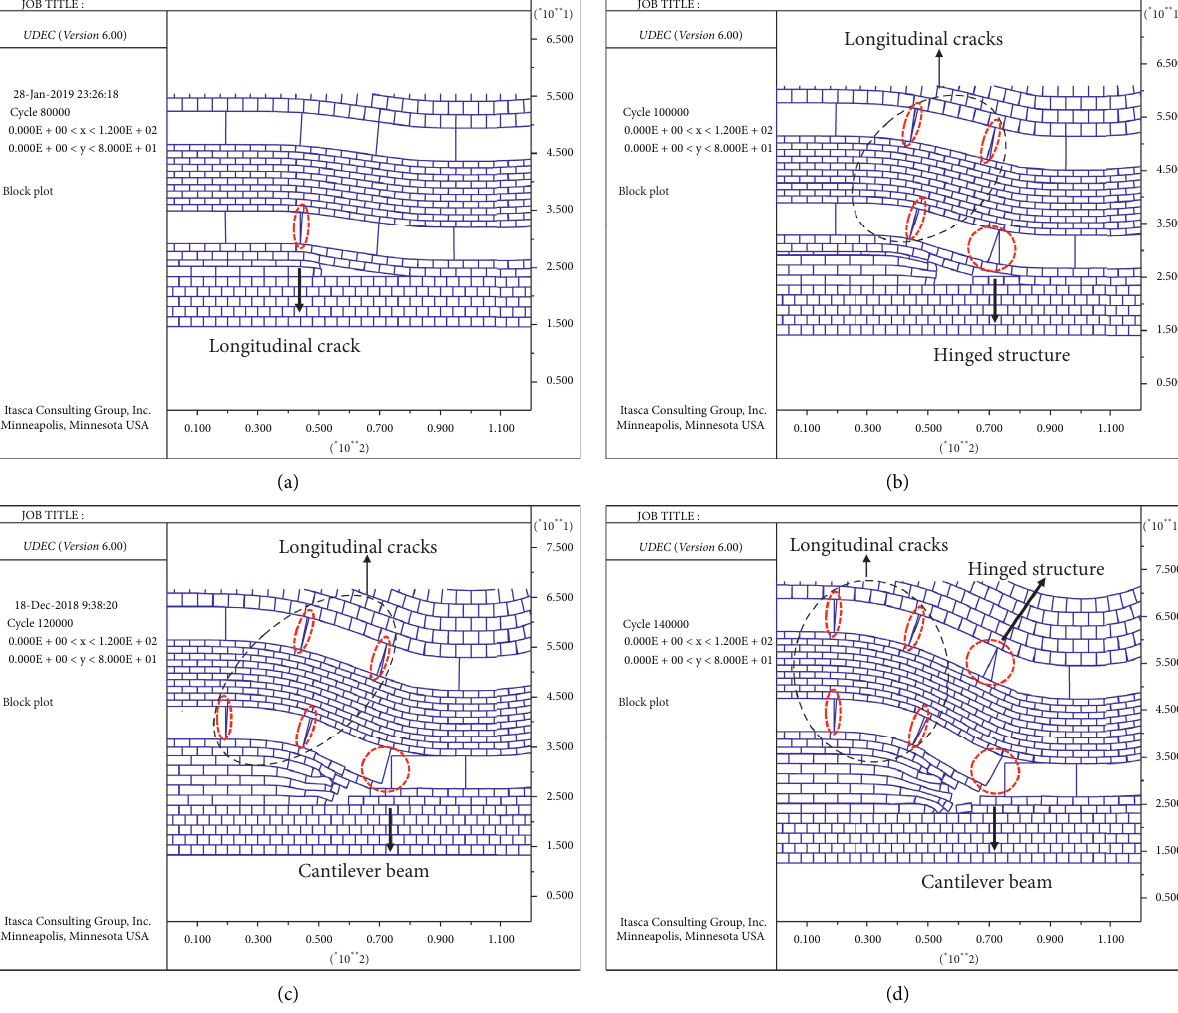
Figure 13: Structure failure characteristics of key stratum in different coal seam thicknesses. (a) 5 m. (b) 10 m. (c) 15m. (d)